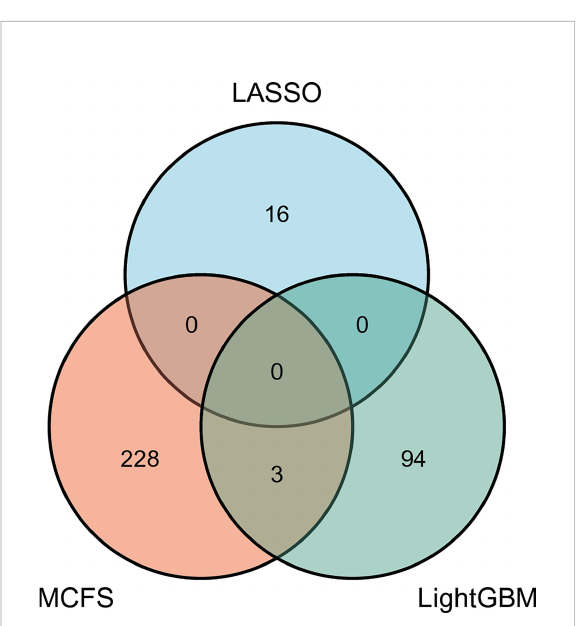
FIGURE 6 Venn diagram to show the intersection of the optimal gene sets for MCFS, LightGBM, and LASSO. Three genes are contained in two optimal gene sets, indicating their